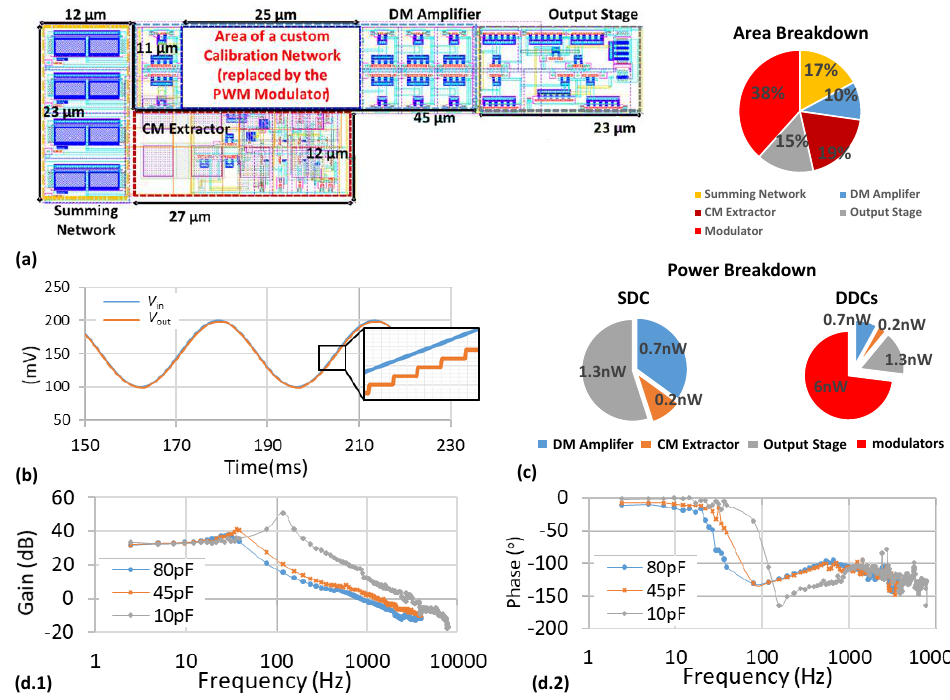
Figure 4. ( a ) DB-OTA layout and Area breakdown ( b ) V in and V out at 30 Hz frequency, 50 mV peak amplitude and C out = 80pF ( c ) Power breakdown ( d.1 , d.2 ) ULV DB-OTA frequency